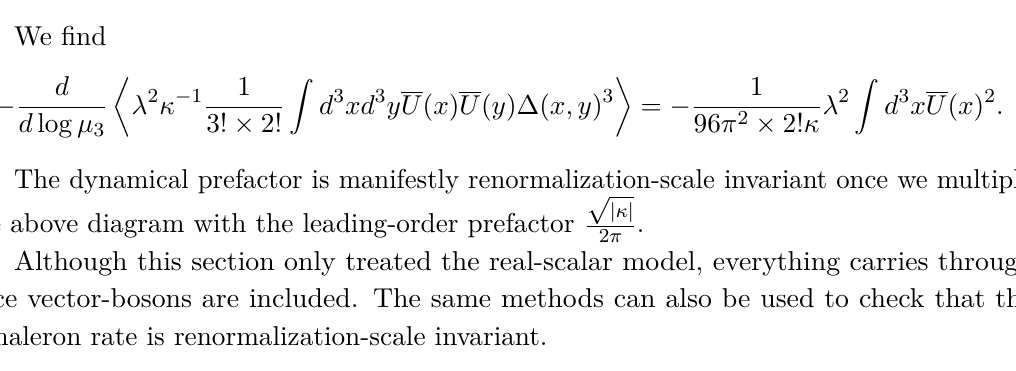
Figure 11 . Two-loop diagram with external-current